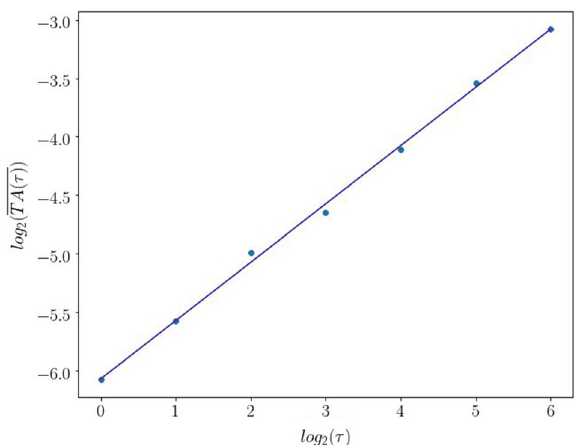
Fig. 4 Linear regression of the TA method